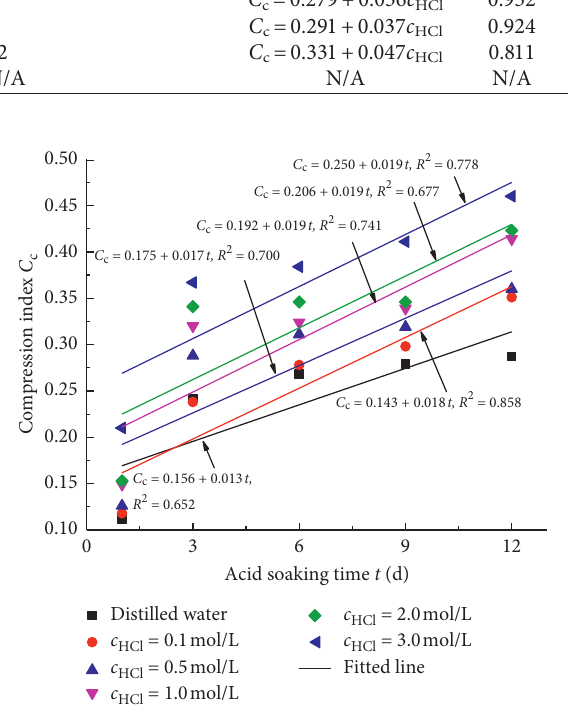
Figure 5: Compression index C